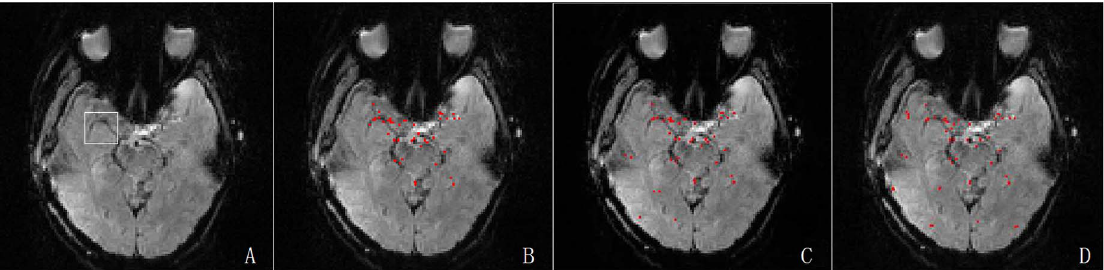
Figure 3. Results of AIF detection based on different clustering methods. The first sub-figure showed the optimal slice image of the randomly selected subject for clustering analysis which was extracted from the first volume of a series of dynamic images, and the right MCA was highlighted by the white rectangle. Sub-fig. B, C and D illustrated the results obtained using AH, k -means and FCM clustering where the red points represented the arterial areas.